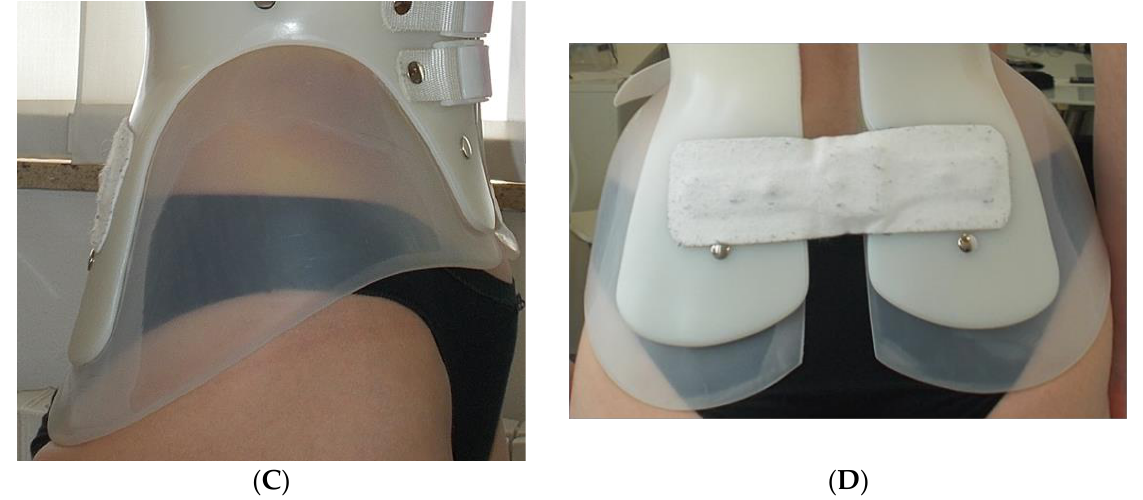
Figure 1. The two types of very rigid braces compared in the study. ( A ). Classical Sforzesco very rigid brace (VRB group). ( B – D ). Sforzesco very-rigid brace with the Free Pelvis innovation (FBP group). Posterior full brace view ( B ) and focus on the Free Pelvis innovation on the sagittal ( C ) and frontal ( D ) plane.